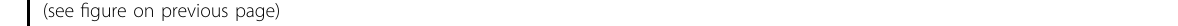
Fig. 1 COATE-seq suppresses allelic hybridization bias. a Enrichment of targeted genomic region by liquid-phase hybridization. Probe and target strand pairing is a reversible process, characterized by an equilibrium constant. The equilibrium constant for a probe complementary to the target sequence (K) is larger than that for its target sequence with a variant ( K ’ ). b Unlike conventional (CON) probes, COATE probes do not discriminate reference and alternative alleles, and thus the difference between K COATE and K COATE ’ is smaller than that of K CON and K CON ’ . Two representative DNA fragments with different hybridization equilibrium constants were shown for conventional and COATE probes. c The CAF (central allelic fraction) in maternal heterozygous loci of 12 pregnant women ’ s plasma samples was signi fi cantly higher and closer to 0.5 when the COATE probes were used at hybridization temperature of 65 °C. The experiment was repeated three times. d The reduction in hybridization allelic bias was also signi fi cant at hybridization temperature of 68 °C using eight pregnant women ’ s plasma samples. The experiment was repeated three times. e The CV of AFs was compared between COATE-seq and CON-seq (enrichment performed by COATE and conventional probes, respectively) at hybridization temperature of 65 °C. The ratios were shown for the CV using COATE-seq and CON-seq at loci where the mother was homozygous for the reference allele (BB), homozygous for the alternative alleles (AA), and heterozygous (AB). Paired t -test was used in c – e for the comparisons; * P < 0.05, ** P < 0.01, *** P < 0.001, and **** P < 0.0001. f , g The comparison of the FF calculation using the COATE-seq and CON-seq methods. FF was calculated for 102 male pregnancies based on the SNP and canonical Y-chromosome